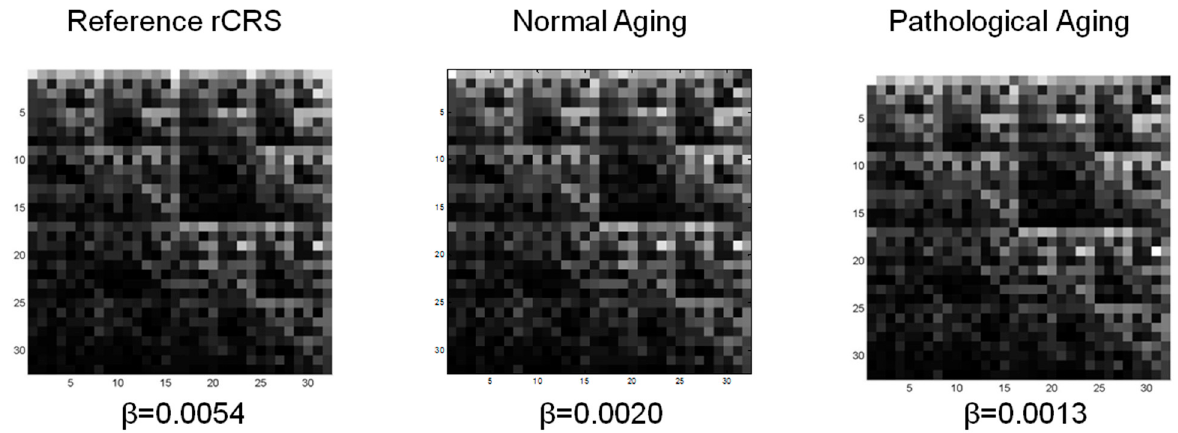
Figure 4. Examples of mtDNA sequence images generated by the CGR method. CGR matrices 2 5 × 2 5 (32 × 32) and related lacunarity parameter β values are shown for mtDNA sequences from rCRS ( left ), a subject of the nA group ( middle ), and a pA patient ( right ). CGR: Chaos Game Representation; rCRS: revised Cambridge Reference Sequence; nA: normal aging; pA: pathological aging.